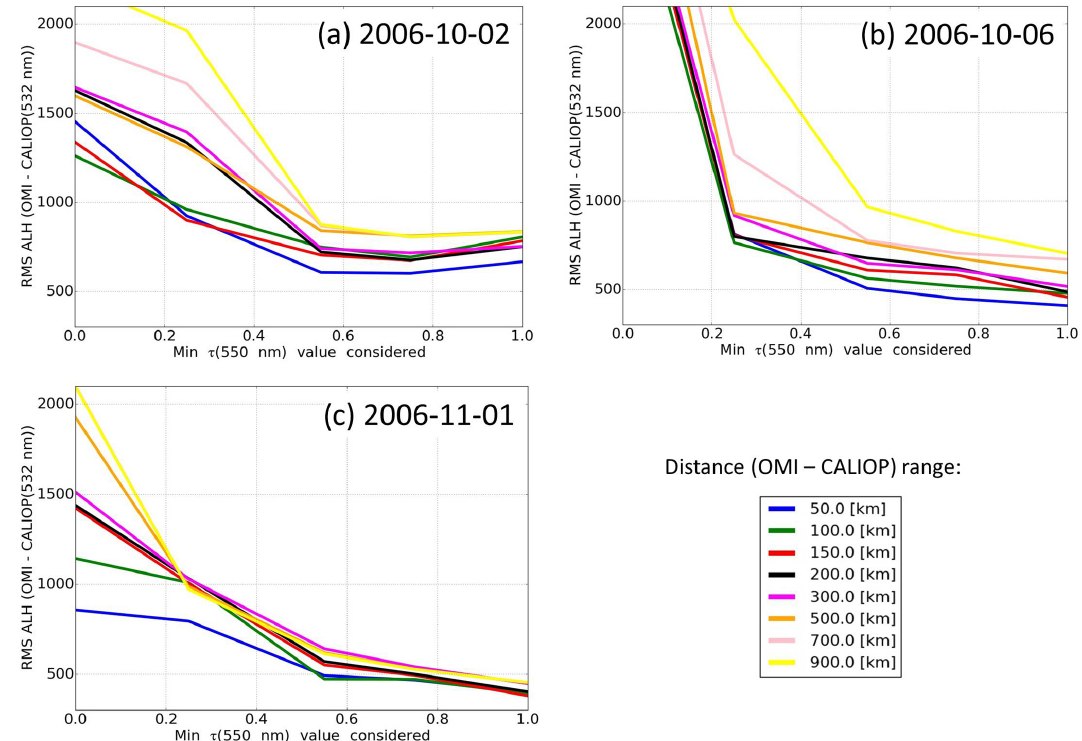
Figure 4. Root-mean-square (RMS) deviation between collocated retrieved OMI ALH and derived CALIOP ALH (532nm) (see Sect. 4.1) for urban and industrialized cases over eastern China as a function of minimum MODIS τ( 550nm ) and distance between OMI and CALIOP ground pixels: (a) 2 October 2006, (b) 6 October 2006, and (c) 1 November